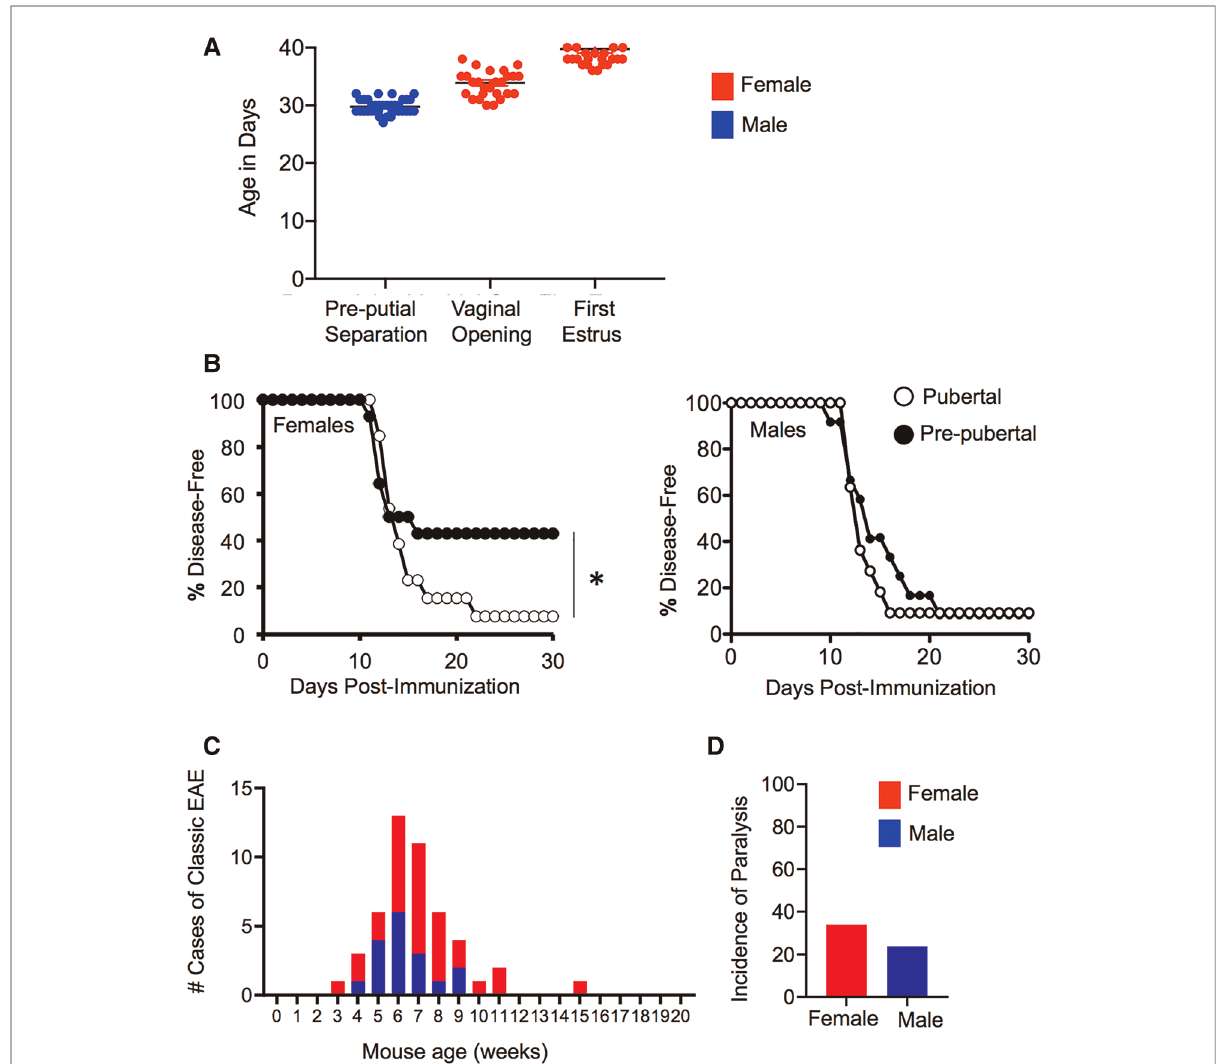
FIGURE 1 Mice are more prone to EAE post-puberty in induced and T cell receptor transgenic models. ( A ) Puberty can be estimated in female mice by measuring vaginal opening ( fi rst sign), which is con fi rmed by fi rst estrus or in male mice by measuring the age at pre-putial separation (when the prepuce can be easily separated from the glans penis). Shown is the mean+SEM age of pre-putial separation in male ( N =36), and vaginal opening and fi rst estrus in female ( N =28) C57BL6/J mice. ( B ) Incidence of EAE observed in female and male SJL/J mice induced at 8 weeks of age with PLP p139-151/CFA that had received a pre-pubertal gonadectomy or sham surgery at the age of 4 weeks. Data shown represents the disease-free survival in mice over 30 days of observation. N =14 for pre-pubertal females (pre-pubertal oophorectomy), N =15 for post-pubertal female (pre-pubertal sham surgery), N =11 for pre-pubertal male (pre-pubertal castration), N =12 for post-pubertal male (pre-pubertal sham surgery). *Signi fi cant by Log-rank test ( P <0.05). ( C,D ) The number of cases of spontaneous EAE ( C ), and the incidence of paralysis ( D ) in MOG TCR transgenic mice over a period of 2